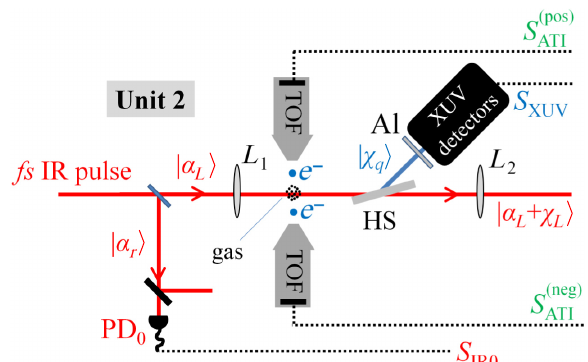
FIG. 10. A more detailed scheme of unit 2. Here L 1 is an IR focusing lens. The arrangement with the TOF spectrometers can be used for measuring the ATI spectra associated with positive and negative electron momenta. HS is a harmonic separator that FIG. 11. Calculated HHG and ATI spectra using the QPROP transmits the IR field and reflects the high harmonics towards the software [119]. Panels (a) and (b) respectively show the HHG XUV detectors. Al is a thin aluminum metal filter that transmits and ATI spectra produced by the interaction of xenon atoms with the harmonics with q ≥ 11 (harmonics in the plateau and cutoff a linearly polarized laserpulse, with a sinusoidal squared enve- region of the spectrum). In this way we eliminate the contribution lope, of intensity 8 × 10 13 W / cm 2 and about 30-fs duration. In of low-order harmonics that are mainly produced by multipho- (b) the photoelectron spectra corresponding to direct and rescat- ton processes. Additionally, the presence of a metal filter is an tered photoelectrons with positive ( p > 0) and negative ( p < 0) experimental requirement for blocking any residual part of the momenta are shown with different colors. Panels (c) and (d) IR beam reflected by the HS. The lens L 2 is used to collimate the respectively show the ATI spectra for negative and positive elec- ( pos,neg ) IR beam after the interaction. With S and S XUV we denote ATI tron momenta produced by the interaction of xenon atoms with the integrated, over a defined region of the spectra, ATI and HHG a linearly polarized laser pulse of intensity 8 × 10 13 W / cm 2 and signals, respectively. When using multicycle driving laser fields, about 5-fs duration. The CEP effect is depicted in the high-energy ≈ S (neg) the use of only one TOF is sufficient as S (pos) . part of the ATI spectra of the negative and positive photoelec- ATI ATI trons. The ATI spectra corresponding to the direct and rescattered electrons are shown with different colors. In all graphs the total ATI spectrum (black solid curve), which includes the contribu- tion of the direct and rescattered electrons, has been shifted by a factor of 100 for visualization reasons. The gray shaded areas depict an example of the controllable (in the width and their ( pos,neg ) and S XUV position in the spectra) integrated areas of the S ATI